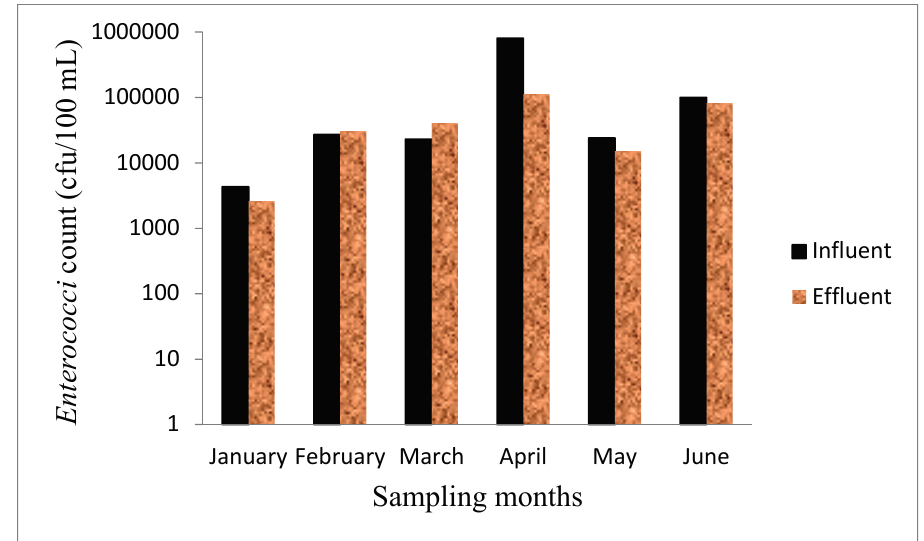
Figure 5. Enterococci count in the influent and effluent of Thohoyandou